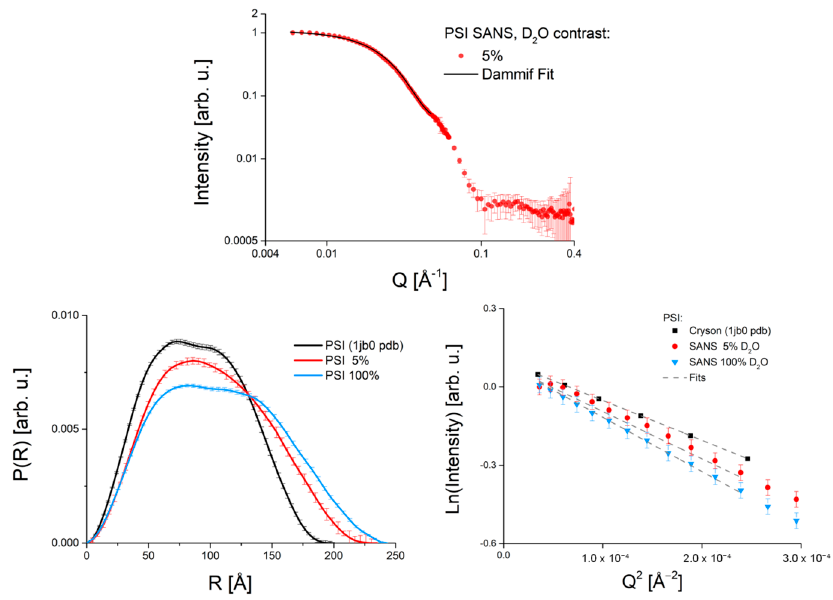
Figure 3. ( Upper ) panel: SANS data of the PSI– β DM complex at a contrast of 5%. Data are taken from Kölsch et al., 2020 [15]. ( Lower left ) panel: Pair distance distribution function P(R) of the PSI– β DM complex in 5% D 2 O (red line) and 100% D 2 O (blue line). For comparison, the P(R) function corresponding to the crystal structure of PSI (pdb code 1jb0 [10]) is also shown. ( Lower right ) panel: Guinier plots of the PSI– β DM complex. Color code is the same as in the left panel. The pair distance distribution function, P(R), calculated from the SANS data